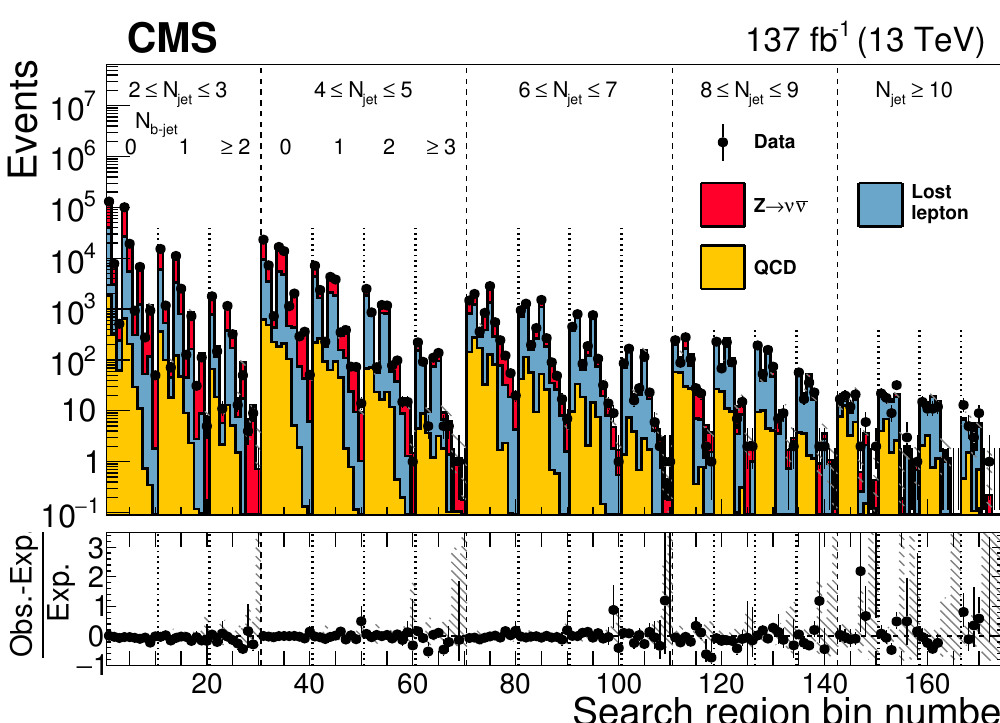
Figure 10 . The observed numbers of events and pre-(cid:12)t SM background predictions in the 174 search bins of the analysis, where \pre-(cid:12)t" means there is no constraint from the likelihood (cid:12)t. The labeling of the bin numbers is the same as in (cid:12)gure 7. Numerical values are given in appendix A. The hatching indicates the total uncertainty in the background predictions. The lower panel displays the fractional di(cid:11)erences between the data and SM